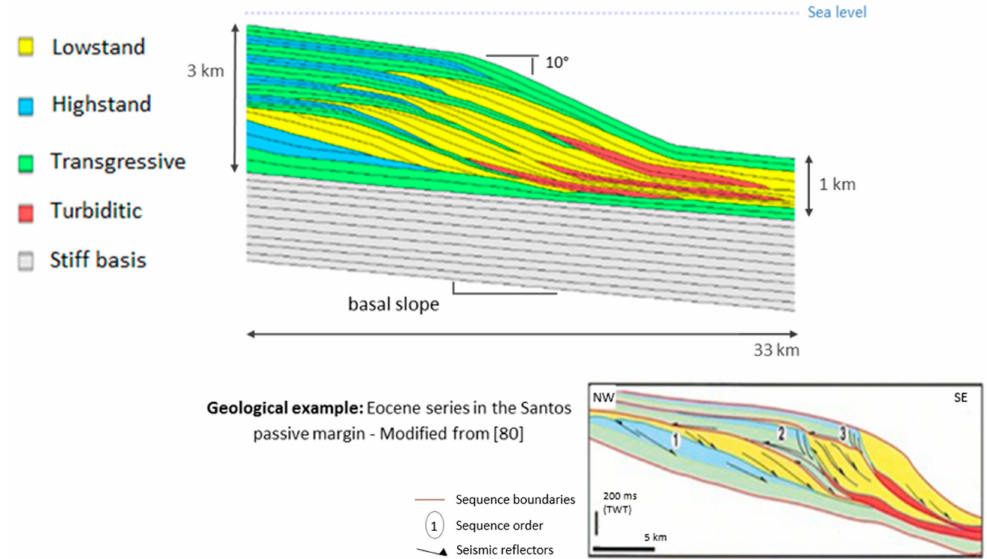
Figure 1. Geometry and stratigraphy of the study-case in the present day; vertical exaggeration × 3.